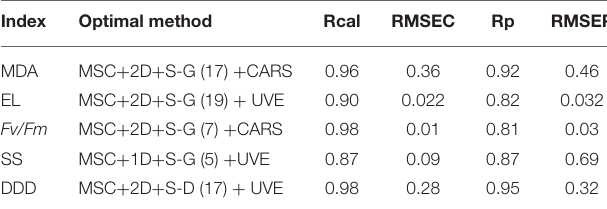
TABLE 3 | Optimal screening